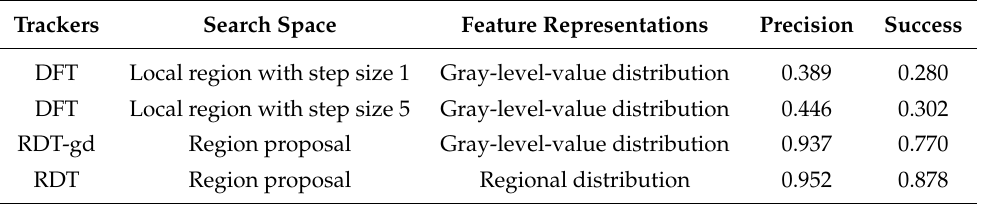
Table 1. Characteristics and tracking results of the distribution-field tracker (DFT), regional-distribution tracker with original gray-level distribution features (RDT-Gd), and RDT.